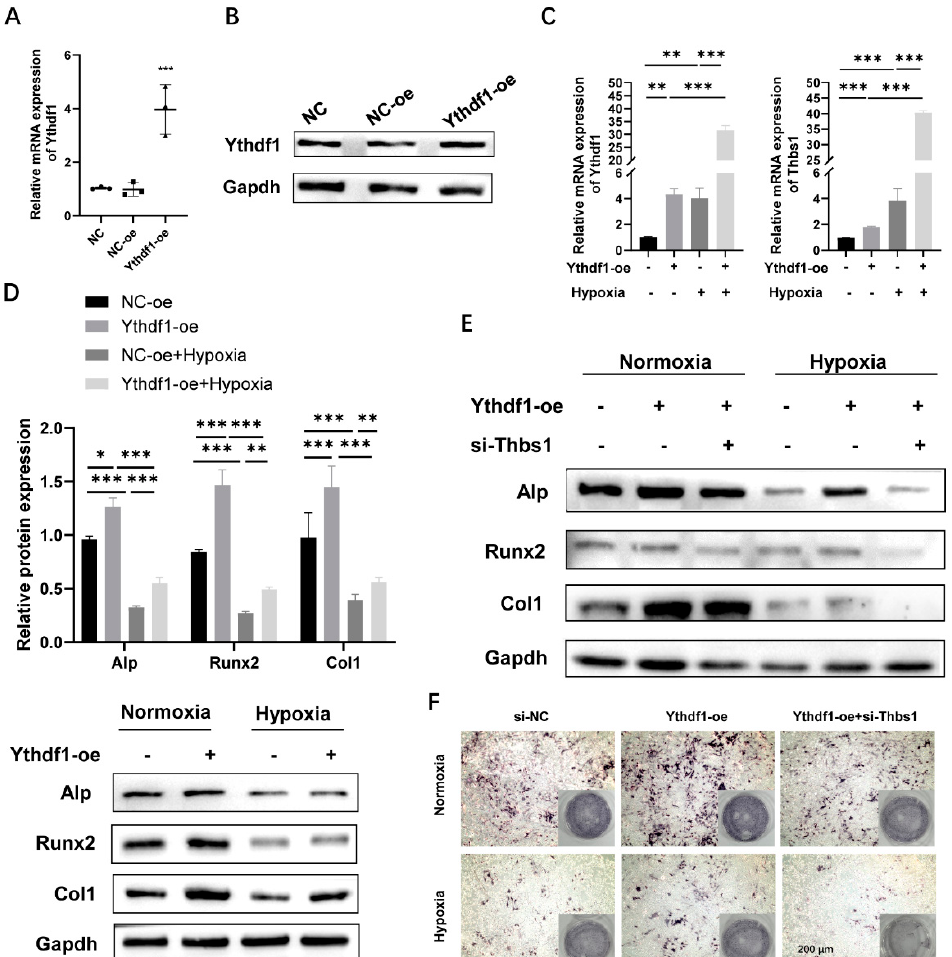
Figure 5. Overexpression of YTHDF1 promotes osteogenic differentiation of MC3T3-E1 cells via YTHDF1/THBS1 pathway under hypoxic conditions. ( A,B ) YTHDF1 mRNA and protein expression determined through qRT-PCR and Western blot after 48 h transfection of siRNAs or negative control in MC3T3-E1 cells. ( C ) mRNA expression of YTHDF1 and THBS1 were examined after overexpression of YTHDF1 under normoxia or hypoxia. ( D ) The protein expression levels of ALP, RUNX2, and COL1 after transfection with overexpressed YTHDF1 were detected by Western blot, compared with NC-oe under normoxia or hypoxia. ( E ) The protein expression levels of ALP, RUNX2, and COL1 after co-transfection of si-Thbs1 with Ythdf1-oe under normoxia or hypoxia. ( F ) ALP staining showed that overexpression of YTHDF1 promoted differentiation of MC3T3-E1 osteoblasts in both normoxic and hypoxic cultures, while the knockdown of THBS1 showed a slight regression of the osteogenic ability promoted by Ythdf1-oe. Scale bar, 200 µ m, n = 3. Results are presented as mean ± SD. The p values were calculated by one-way ANOVA followed by Tukey’s test (* p < 0.05, ** p < 0.01, *** p < 0.001, compared with the control group). YTHDF1, Yth m 6 A RNA-binding protein 1;